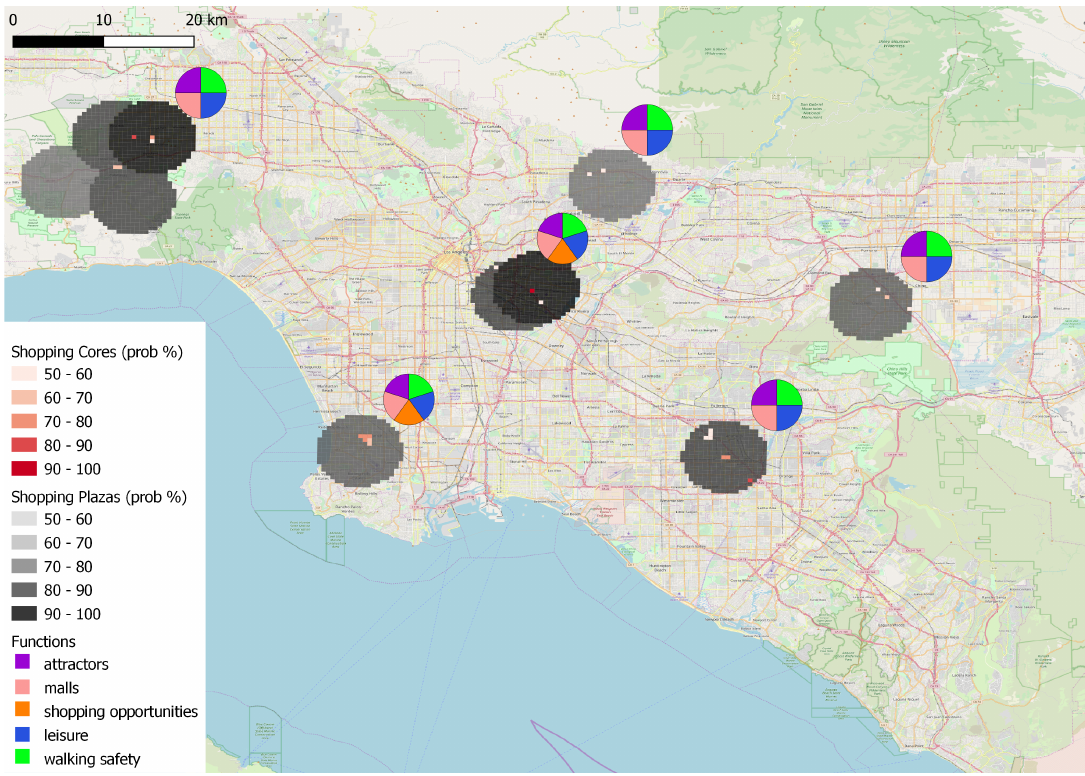
Figure 3. Results without using any of the proposed fusion